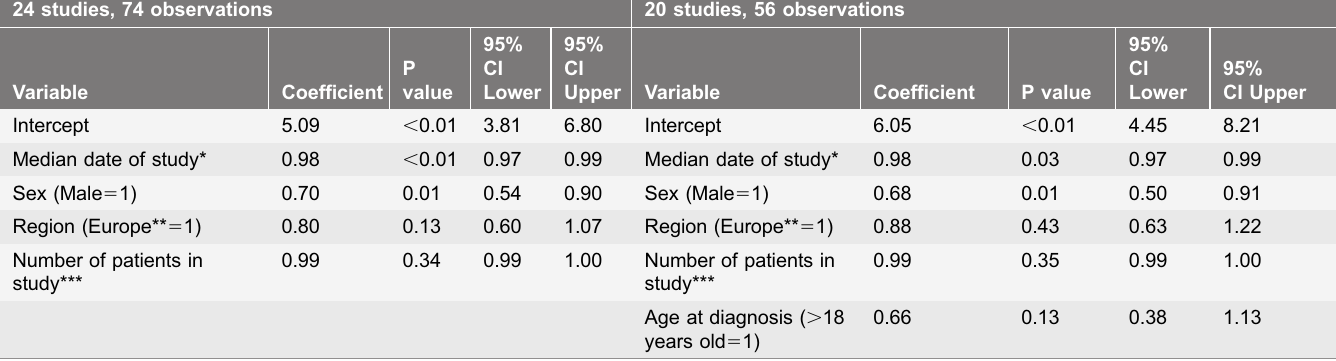
Table 3. Meta-regression results, determining the factors that account for the heterogeneity between different studies’ relative risk of mortality estimates. 24 studies, 74 observations 20 studies, 56